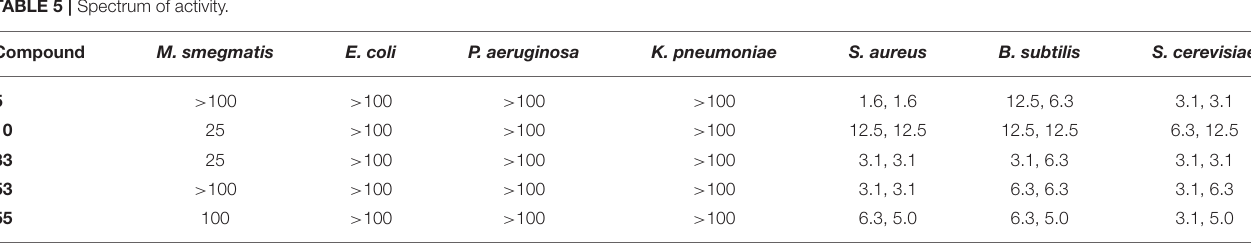
TABLE 5 | Spectrum of activity.